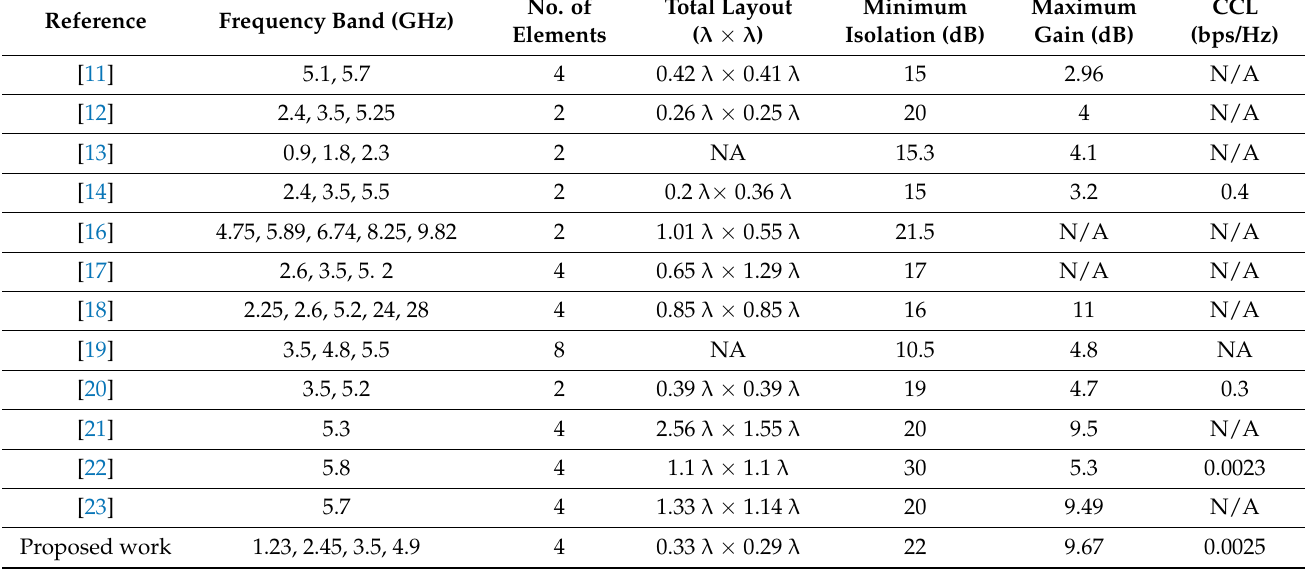
Table 6. Comparison table of the proposed work with recent work include in